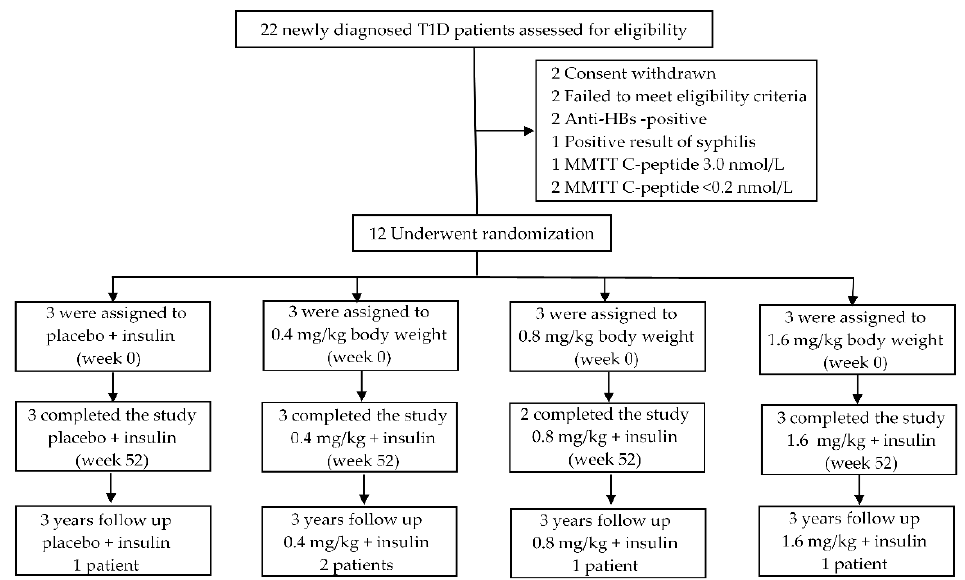
Figure 1. Description of eligible, enrolled, and participating patients in the study. T1D: newly diagnosed T1D patients; anti-HBs: hepatitis B surface antibody; MMTT: mixed-meal tolerance test. The 52-week study period was divided into three stages. During the first stage (week 0–8), Itolizumab was administered through the intravenous route, once a week (dose 0.4 and 0.8 mg/kg/day), or every two weeks (dose 1.6 mg/kg/day). During the second stage (week 9–24), Itolizumab was adminis- tered through the intravenous route every four weeks. At the third stage, all patients received insu- lin up to 28 weeks after the last Itolizumab administration (week 25–52).